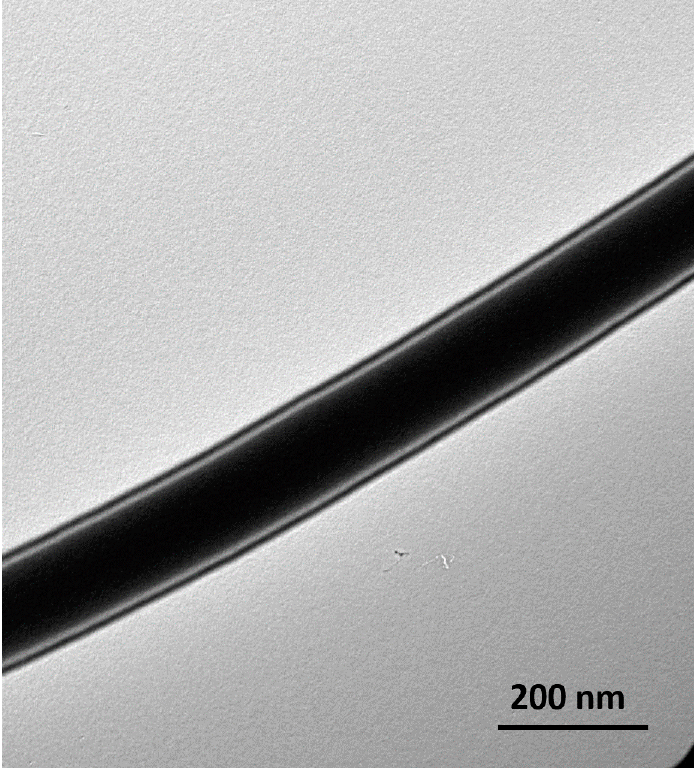
Figure 2. TEM image of drug-loaded coaxial fiber, showing the distinctive fiber layers of the core and shell.